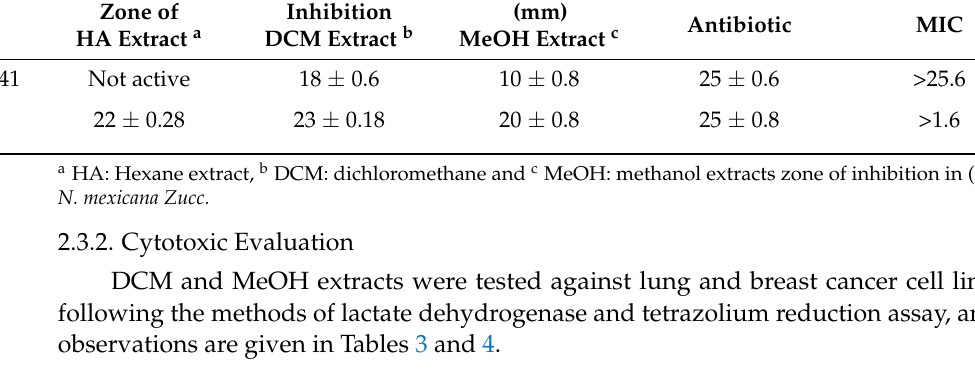
Table 3. In vitro anticancer activity by MTT assay of N. mexicana Zucc. extract.